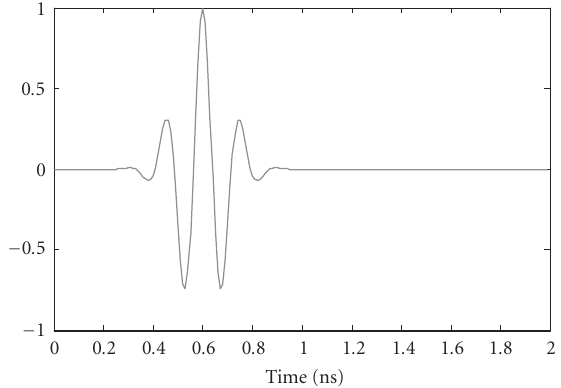
Figure 16: Excitation signal at antenna port: Gaussian impulse with a − 10 dB power bandwidth of 3–10.0